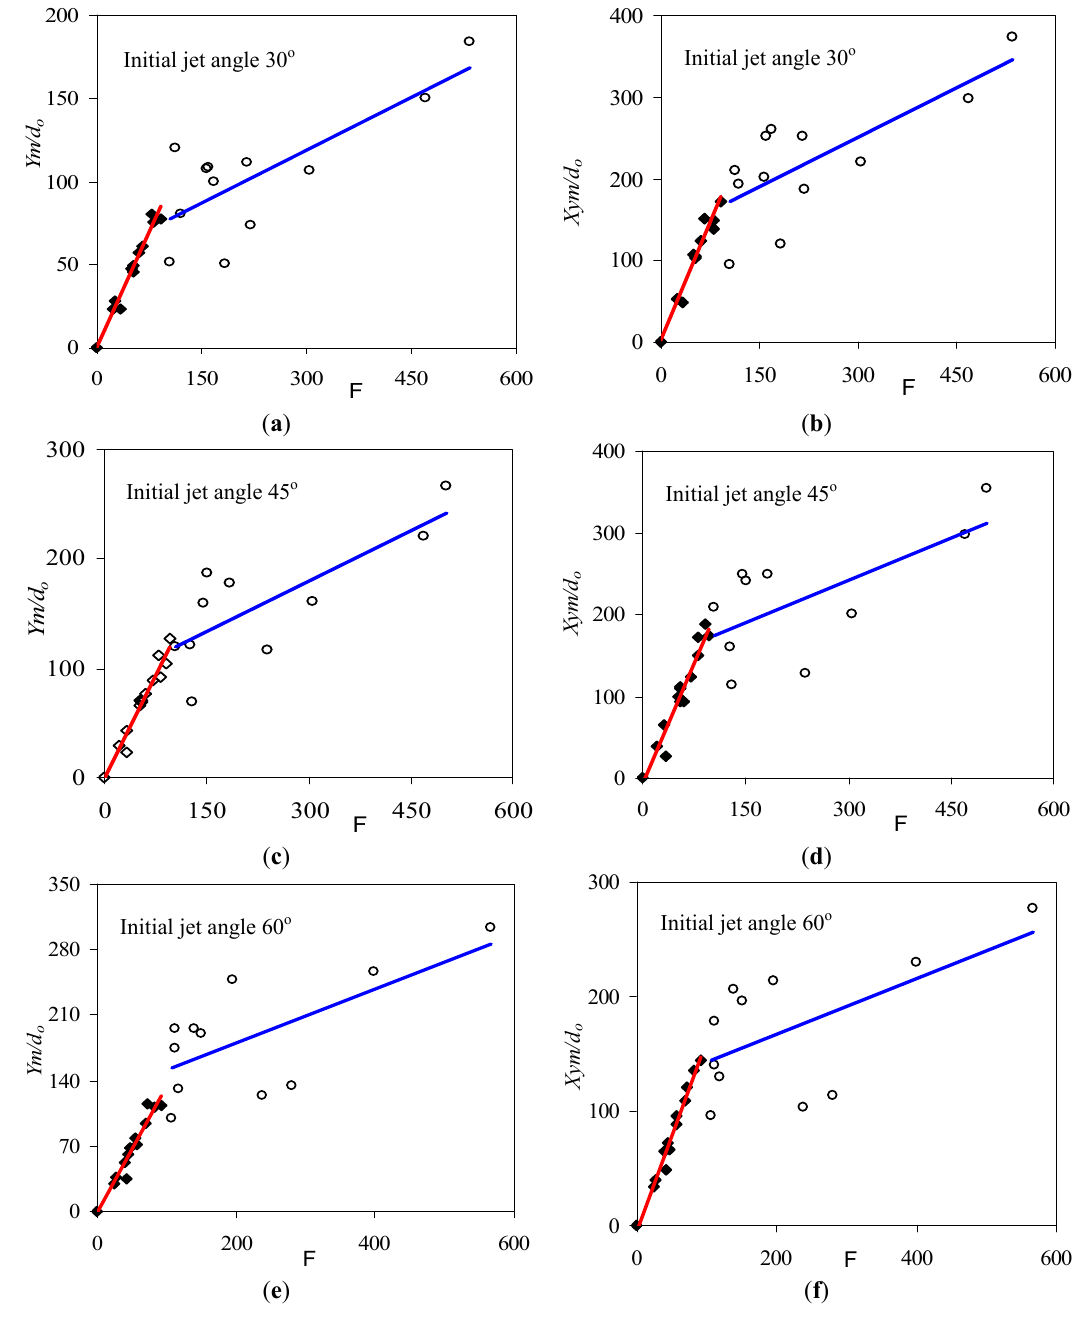
Figure 7. Non-dimensional jet quantities Y initial jet angles ( a – f ) together with linear regression lines fitted for F-values smaller and larger than